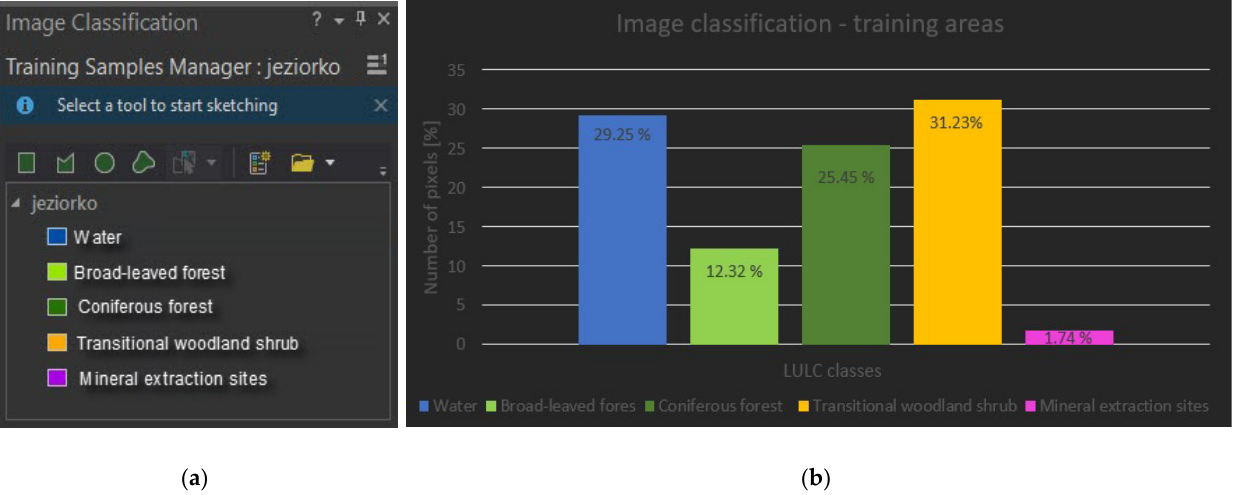
Figure 4. Image classification: ( a ) training samples manager; ( b ) the total number of training areas (Arc GIS Pro, Esri).